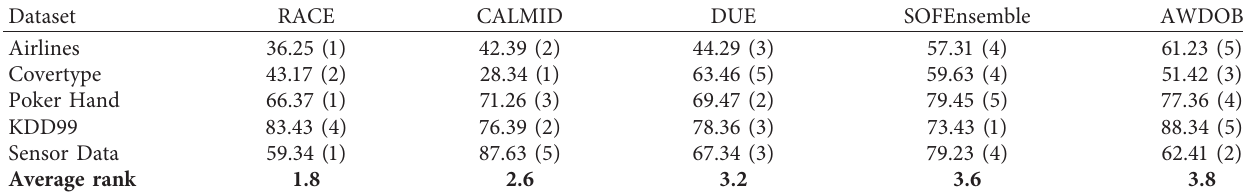
Table 5: Memory consumption of each algorithm on each dataset.